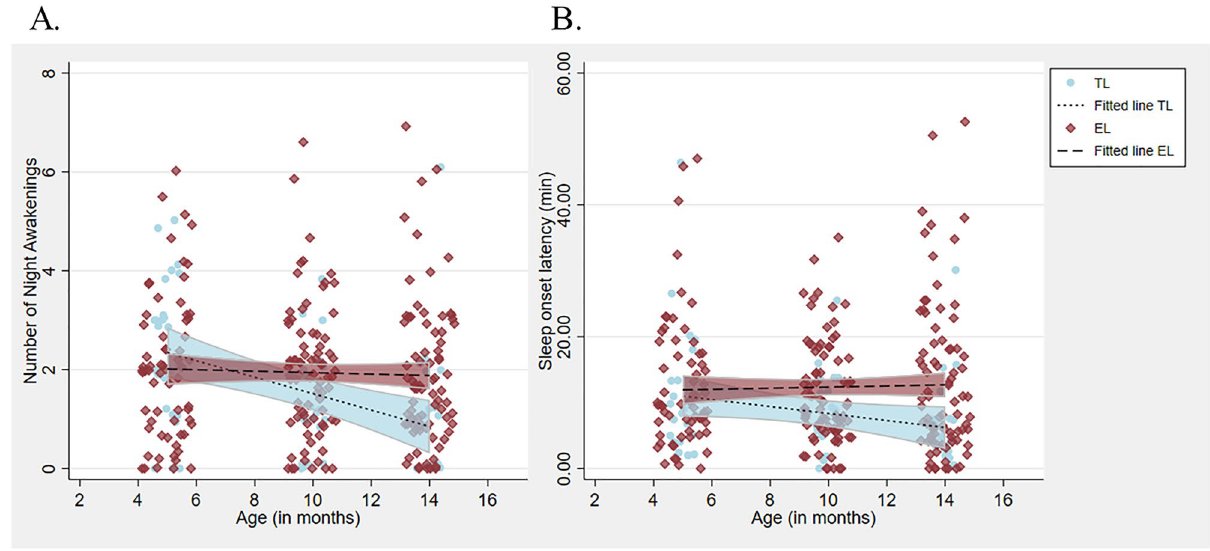
Figure 2. Sleep trajectories from 5 to 14 months. Infants at typical likelihood for ASD (TL) are depicted in blue and infants at elevated likelihood for ASD (EL) are depicted in red. Fitted lines are shaded by the 95% confidence interval. ( A ) The number of night awakenings. ( B ) Sleep onset latency.